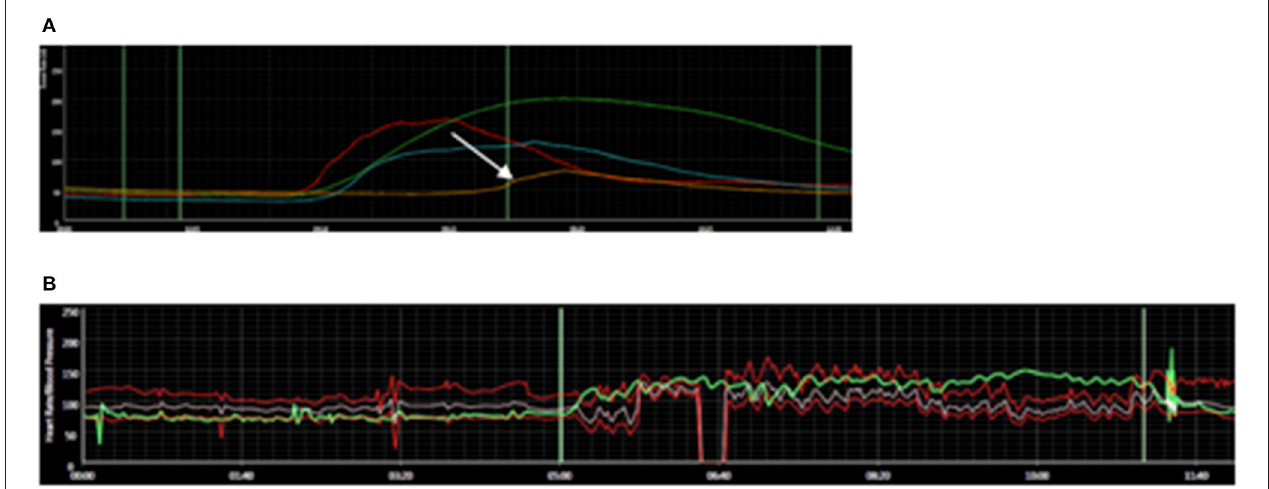
FIGURE 1 | Autonomic Findings in COVID-19 Dysautonomia patient. (A) Reduced sweating on quantitative sudomotor axon reflex testing in the foot (arrow); normal elsewhere. (B) Abnormal, excessive increase in heart rate (61 beats per minute) with head-up tilt. Heart rate is depicted in green. Blood pressure in red.